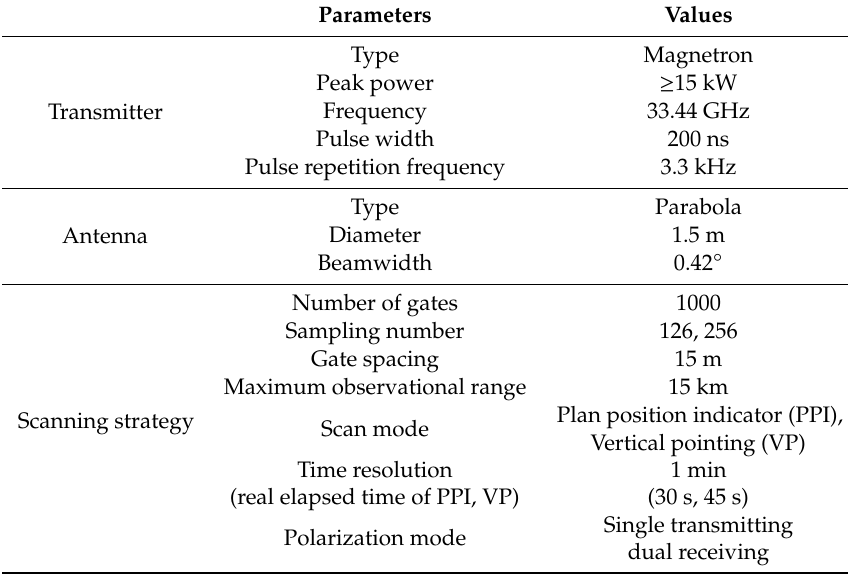
Table 1. Specifications of the Ka-band cloud radar manufactured by Beijing Santel Technology & Trading Corperation, China.